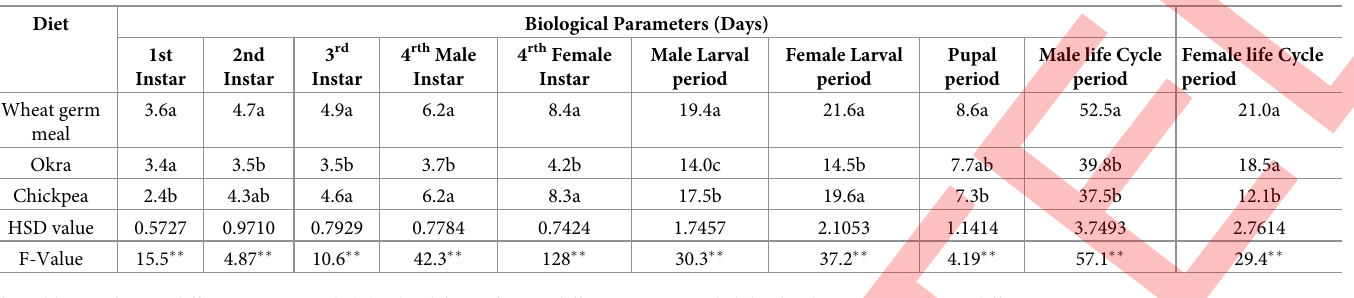
Table 3. Growth and development of Pectinophora gossypiella reared on various treatment diets. Diet Biological Parameters (Days)